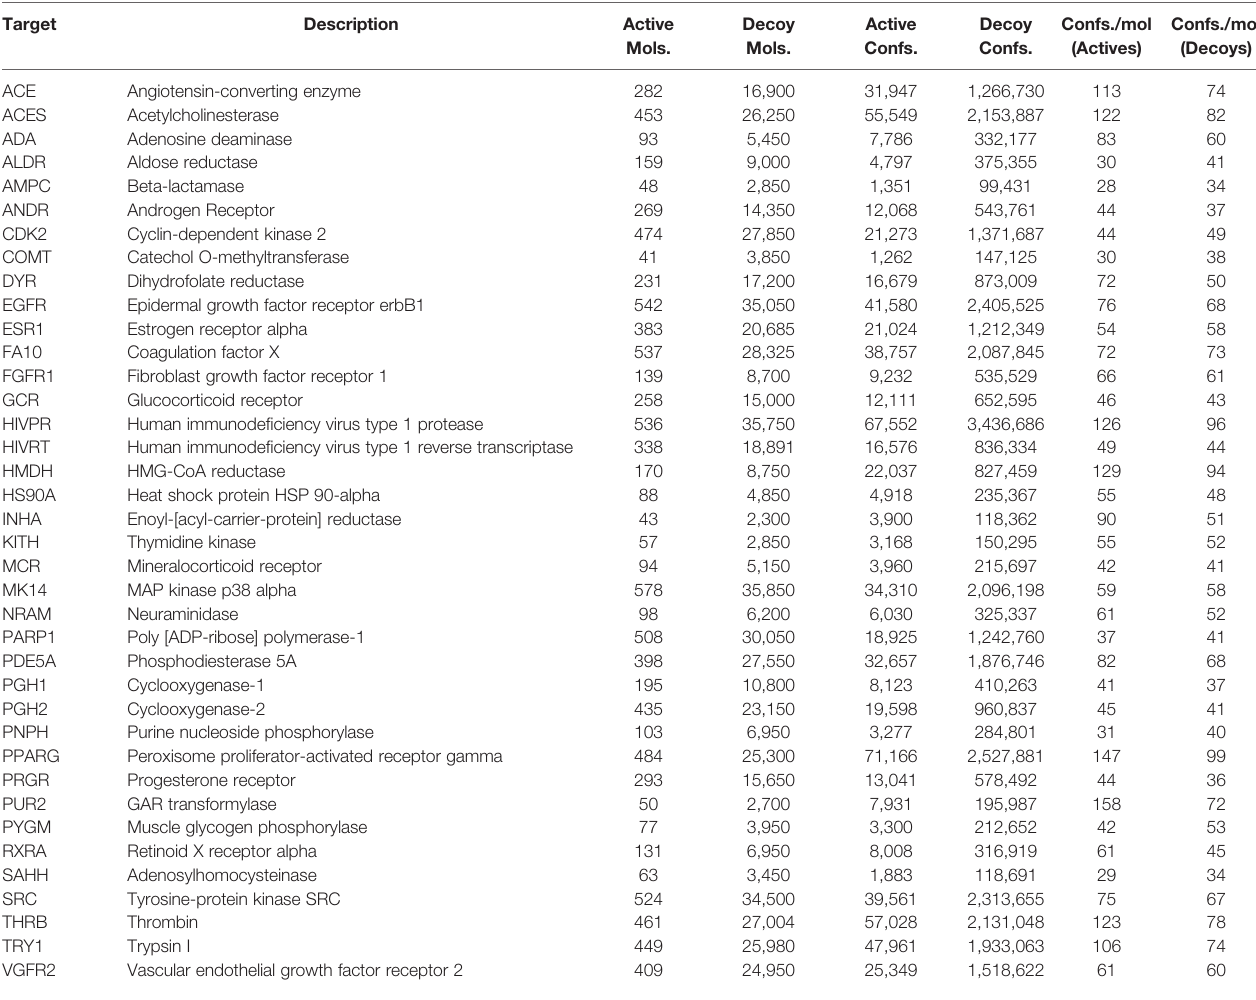
TABLE 1 | The list of 38 protein targets that we considered in this study along with the number of active and decoy molecules that were available for each protein target, and the respective number of active and decoy conformers we generated. These targets correspond to the “ Dud38 ” subset in DUD-E. Target